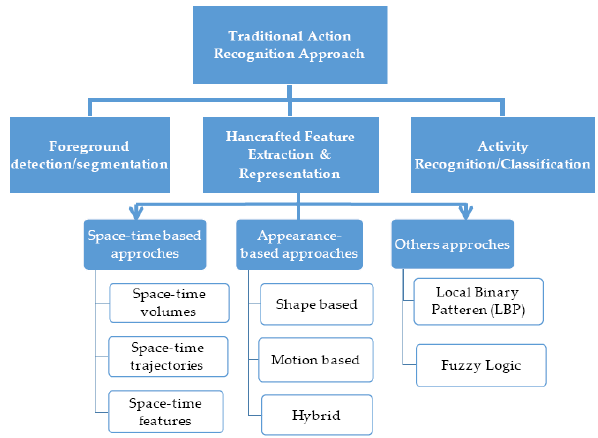
Figure 4. Traditional action representation and recognition approach.